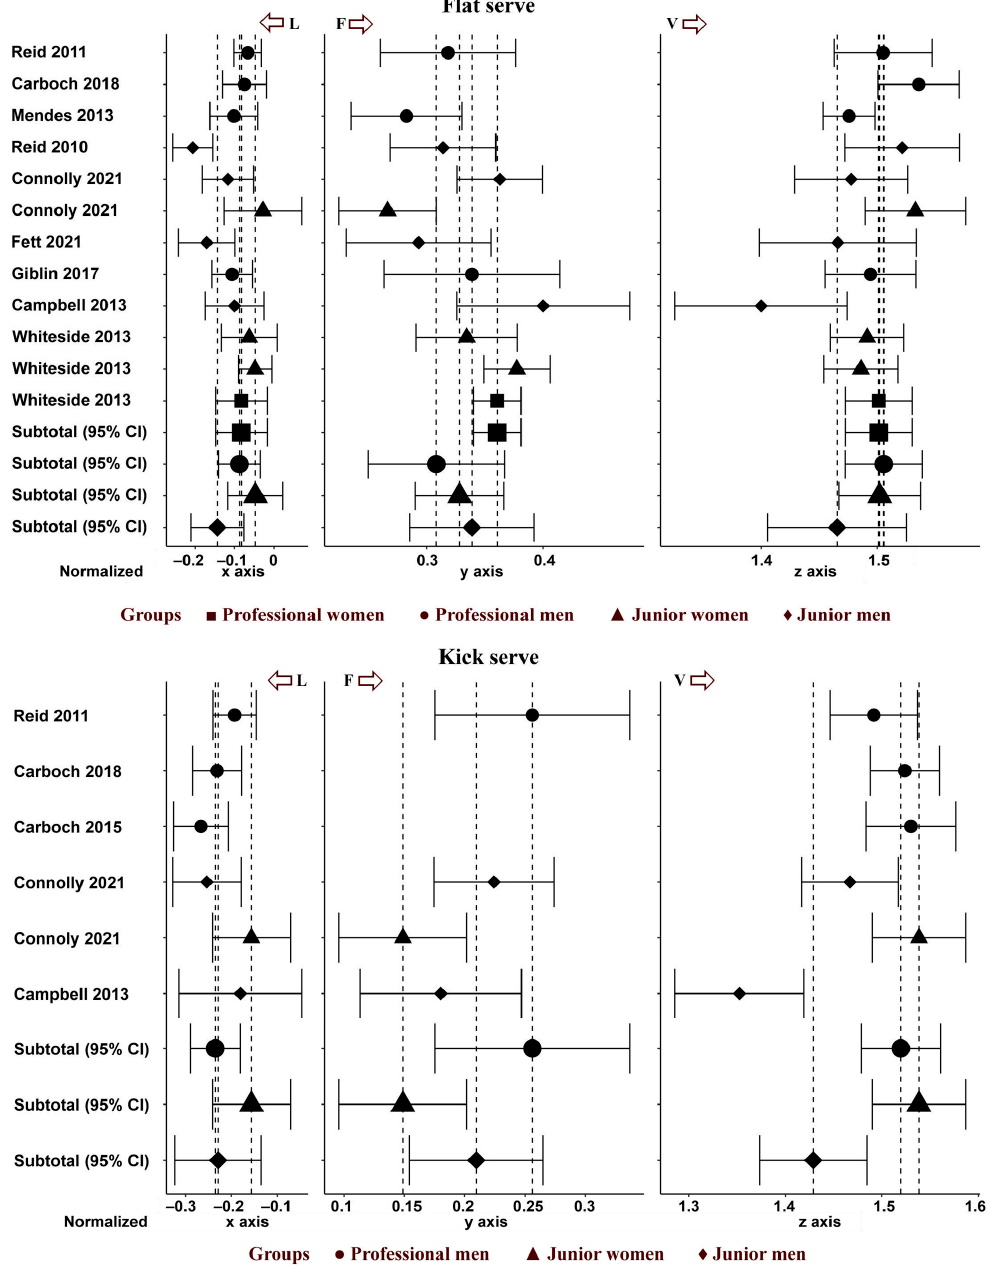
Figure 3. The forest plots present the ball impact location. There are presented the normalized mean and 95% confidence interval of the ball impact location in chosen studies. The subtotal presented a normalized weighted mean and their 95% CIs of the groups divided according to the serve type (upper part = Flat serve and lower part = Kick serve). Note: ← L (leftwards from the origin on the x –axis); F → (forwards from the origin on the y –axis; V → (upwards from the origin on the z –axis. References: [14,17,19,20,26–31].